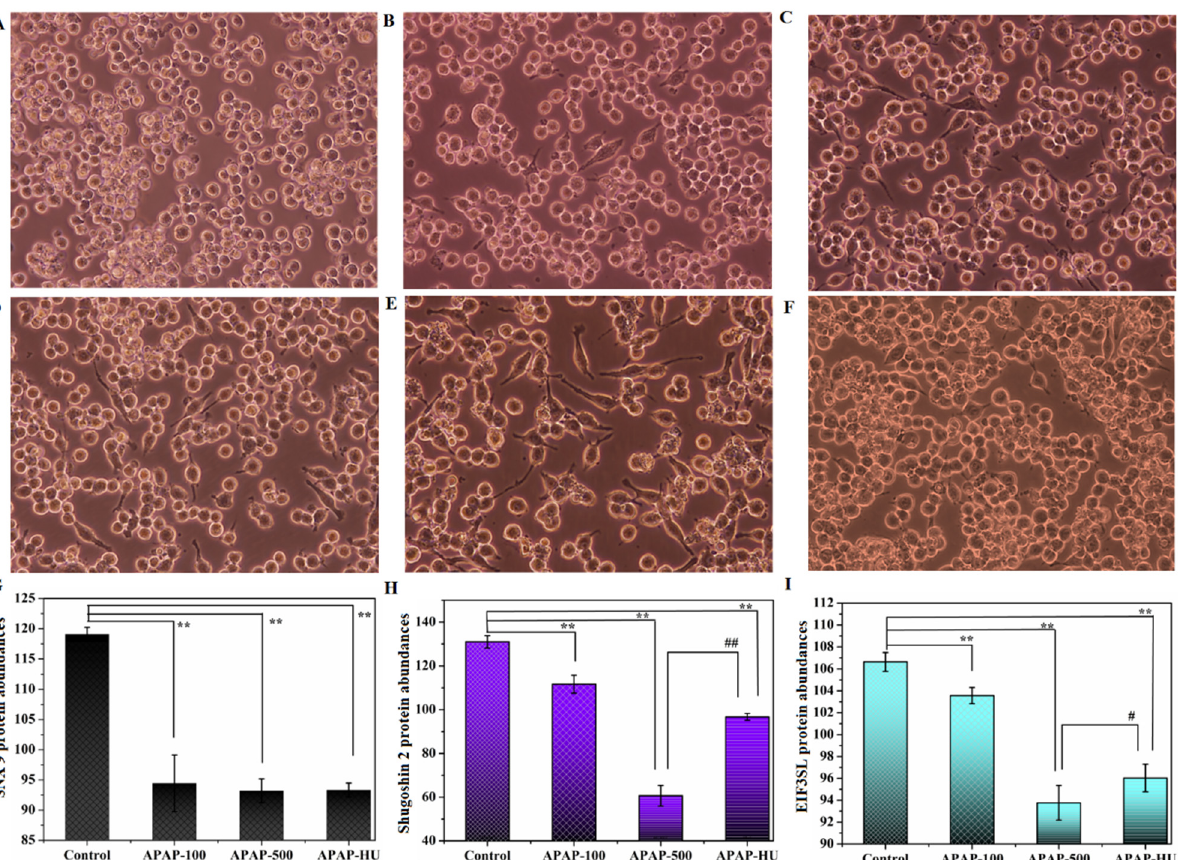
Figure 2. Acetaminophen (APAP) inhibits cell proliferation and regulates the expression of proteins involved in cell division. ( A ) Control group, ( B ) 50 µg/mL APAP group, ( C ) 100 µg/mL APAP group, ( D ) 200 µg/mL APAP group, ( E ) 500 µg/mL APAP group, and ( F ) 500 µg/mL APAP + 5 µg/mL polydatin group. ( G ) Differentially expressed proteins of sorting nexin-9 protein (SNX9). ( H ) Differentially expressed proteins of Shugoshin 2. ( I ) Differentially expressed proteins of eukaryotic translation initiation factor 3 subunit L (EIF3SL) in the control group vs. APAP100 vs. APAP500 vs. APAP500-HU (** p < 0.01 vs. Control; # p < 0.05 vs. APAP-500; ## p < 0.01 vs. APAP-500).